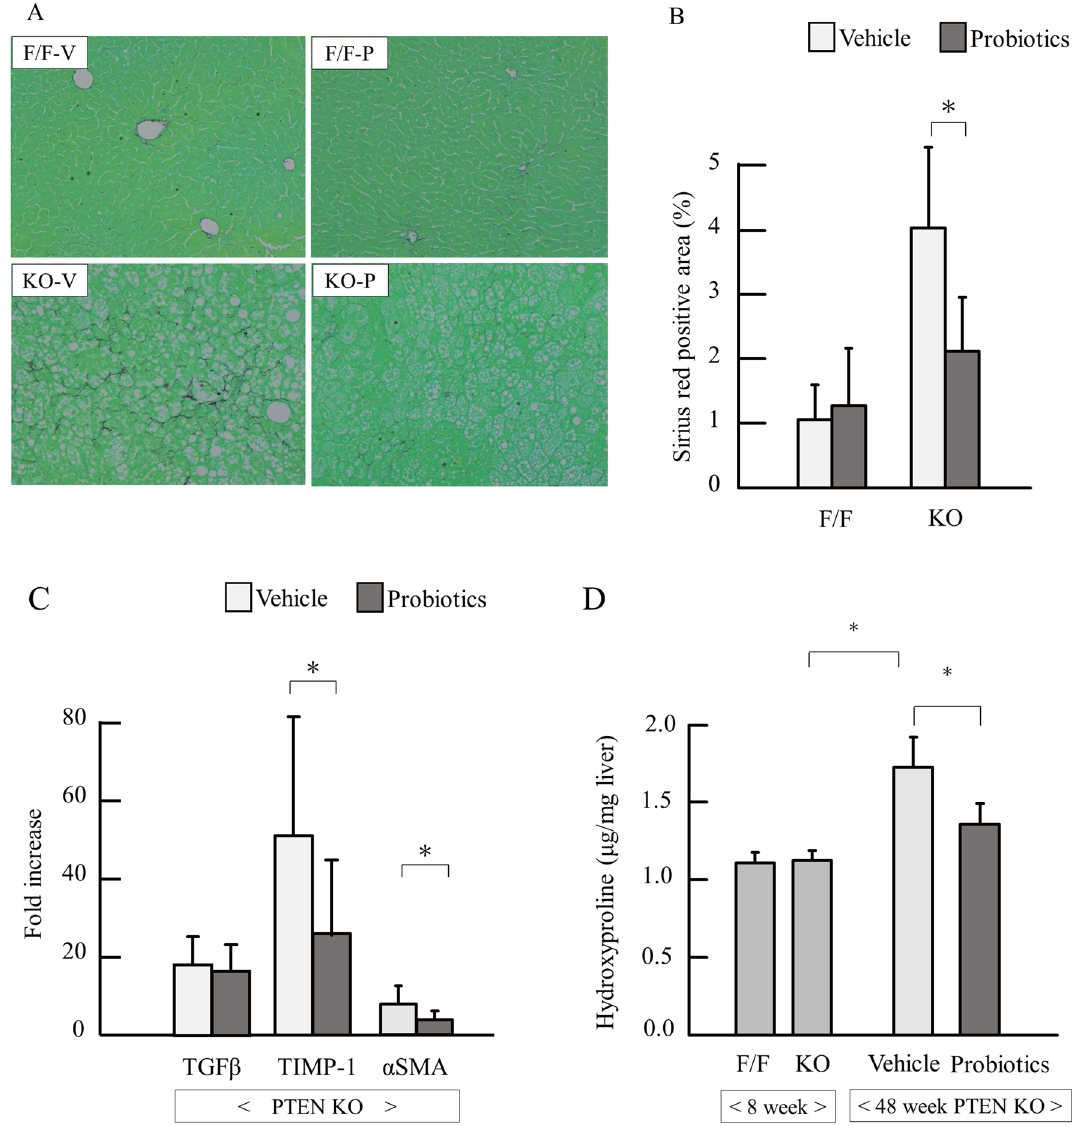
Figure 3. Assessment of liver fibrosis. ( A ) Sirius red staining of the liver. ( B ) Quantification of Sirius red- positive area (each group n = 5). ( C ) mRNA expression of fibrosis markers (each group n = 9–11). ( D ) The content of hepatic hydroxyproline. Groups were analyzed using the student’s t -test. Data were presented as mean ± standard deviation. * P < 0.05. (Experiments in C and D were performed in technically